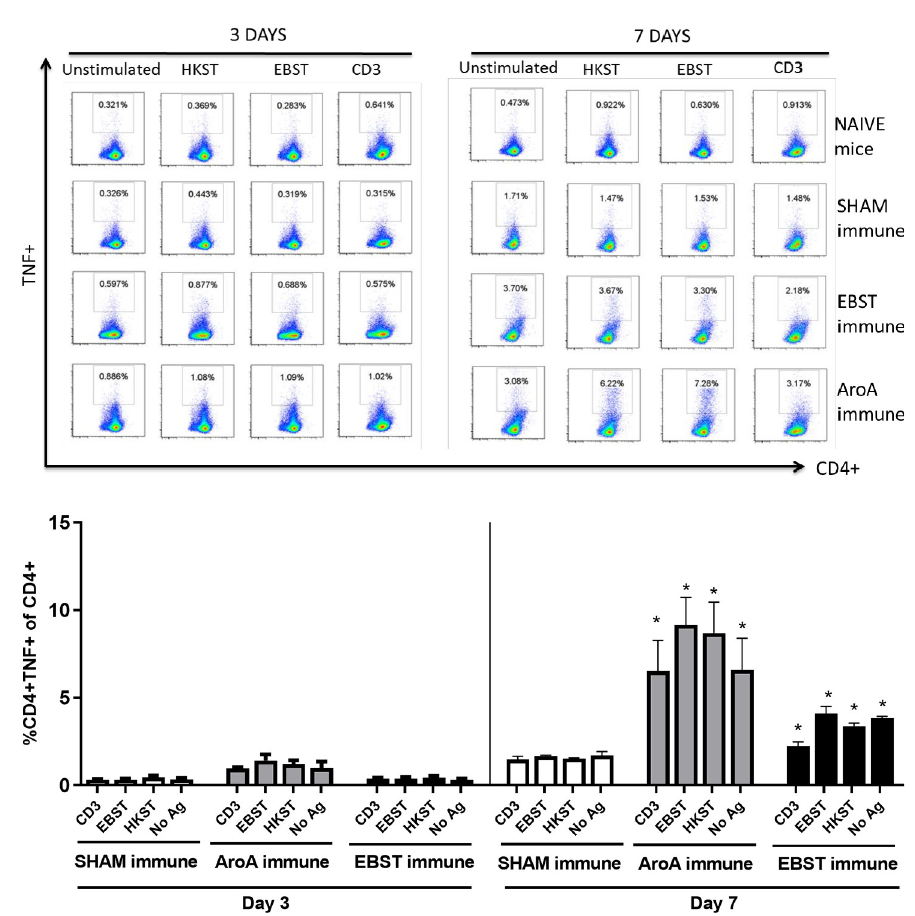
Fig 8. EBST immune mice exhibit Salmonella specific CD4 + TNF + T cell responses during virulent ST challenge. Individual EBST immune, AroA immune, and Sham immune mice were infected with virulent ST and at 3 days and 7 days post infection splenocytes were measured for production of TNFa by antigen specific CD4 + T cells using intracellular cytokine staining (ICS). Antigens used were EBST and HKST (2 x10 7 cells/ well) and anti-CD3 antibody as positive control. Unstimulated splenocytes were included as control. Percentages in the gated region of dot plots indicate the proportion of CD4+TNF+ of total CD4+ splenocytes (Fig 8A) The data represents three-five individual mice per group. The bar graph data represents the mean ± SEM of 3–5 mice per group. Y axis represents percentage of CD4 + TNF + of total CD4 + splenocytes (Fig 8B) on days 3 and 7. Statistics were determined for comparisons between group for each antigen at the indicated day. � , p �